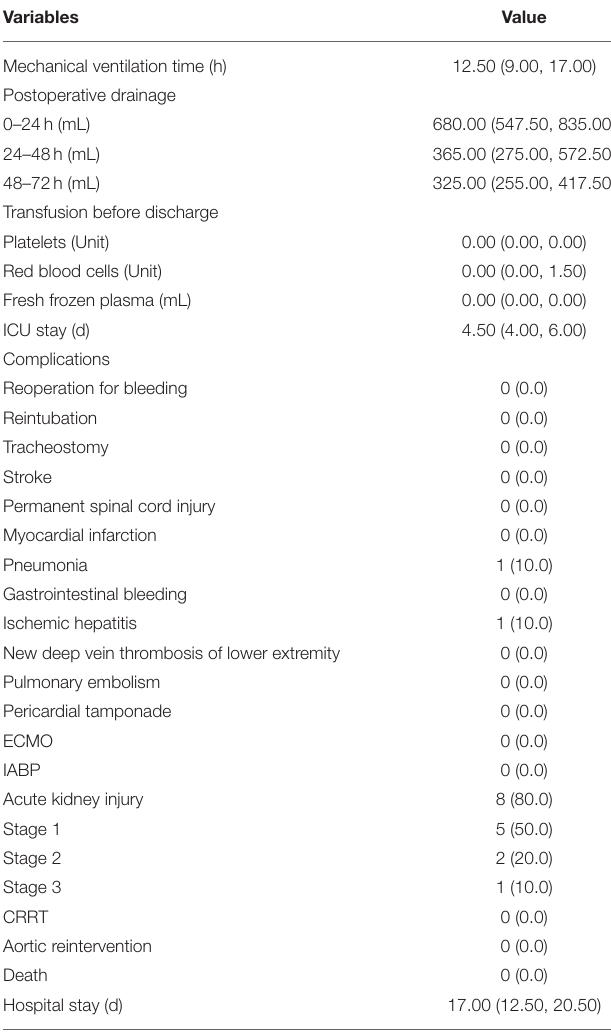
TABLE 5 | In-hospital